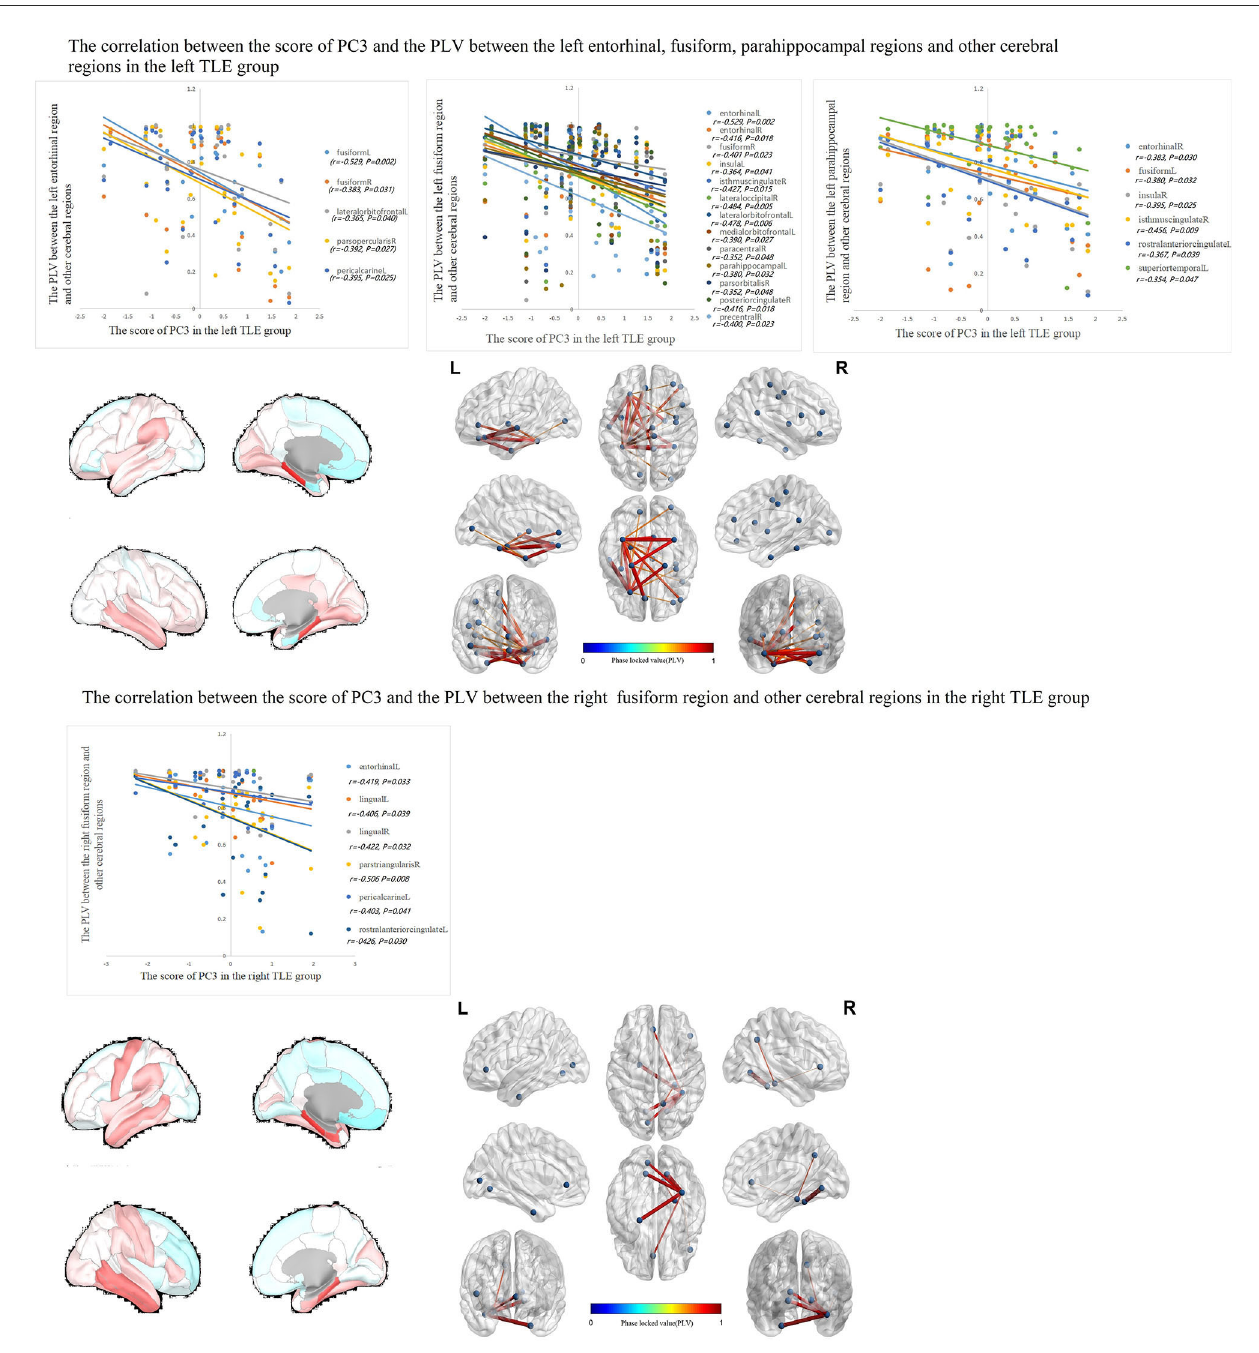
FIGURE4 In the left TLE group, the IED source connectivity between the left temporal lobe and the limbic regions which included the medial temporal lobe, cingulate, and orbitofrontal cortex was negatively correlated with SC3. In the right TLE group, the IED source connectivity between the right temporal lobe and the medial temporal and occipital lobes, cingulate gyrus, and ipsilateral pars triangularis cortex was negatively correlated with